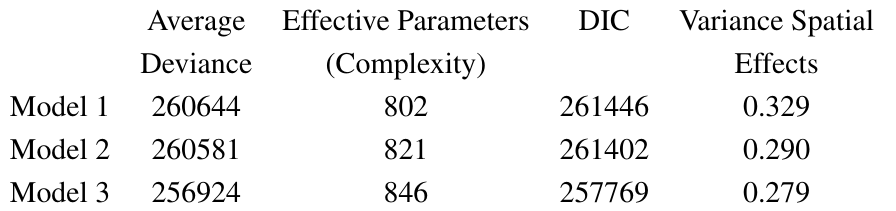
Table 4 . Model fit summary.